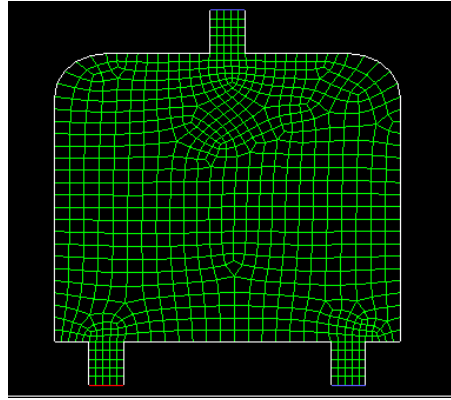
Figure 8. Water flow environment and established grids.